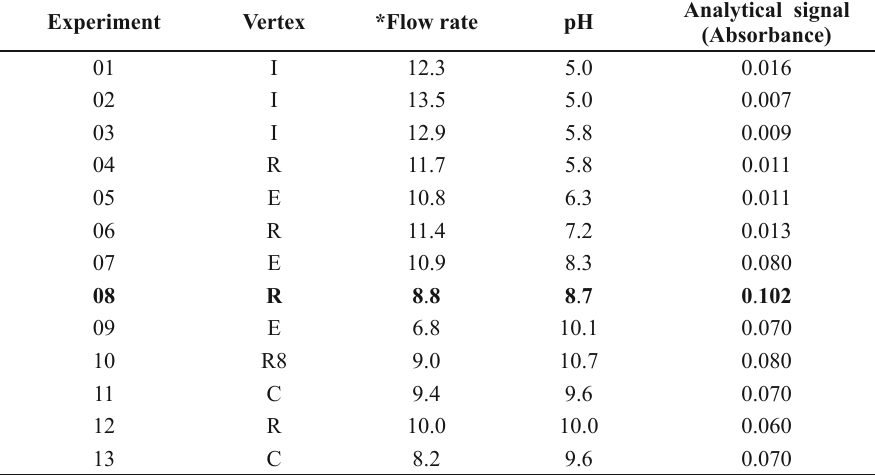
Values obtained through the simplex optimization.